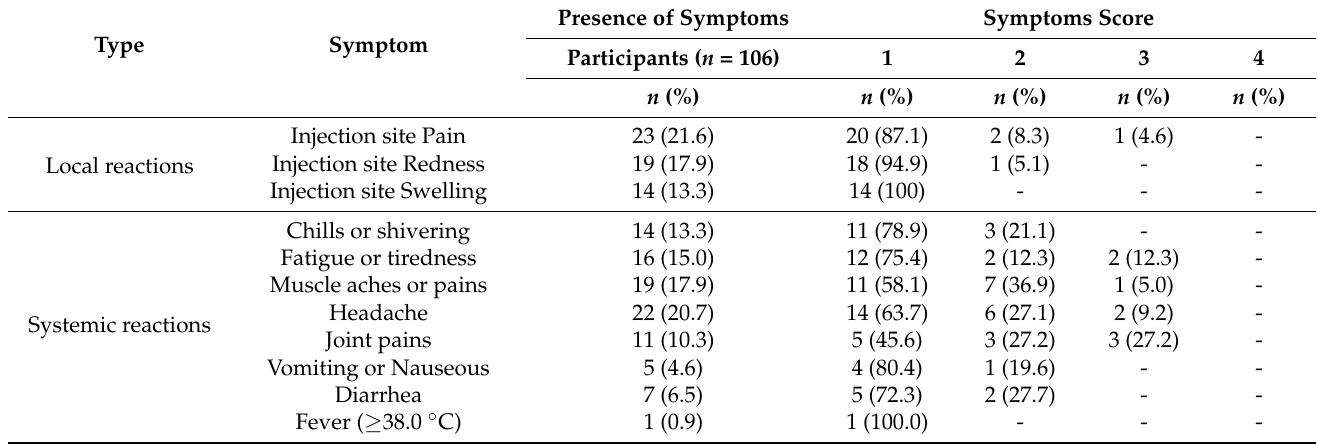
Table 3. Symptoms experienced after the second vaccination with BNT162b2 (Pfizer/BioNTech) vaccine (Conmirnaty ®